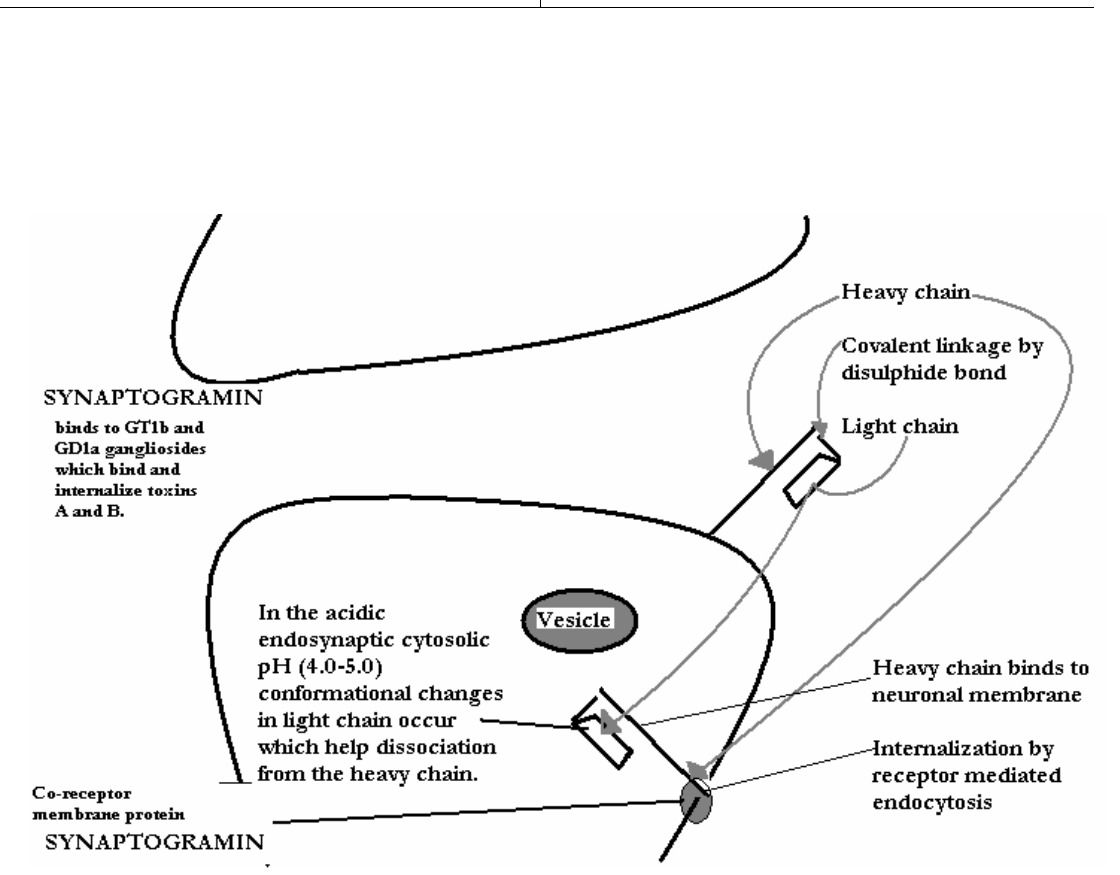
Figure 3: Heavy chain binds to the receptor and once inside the cell the light chain separates at the covalent